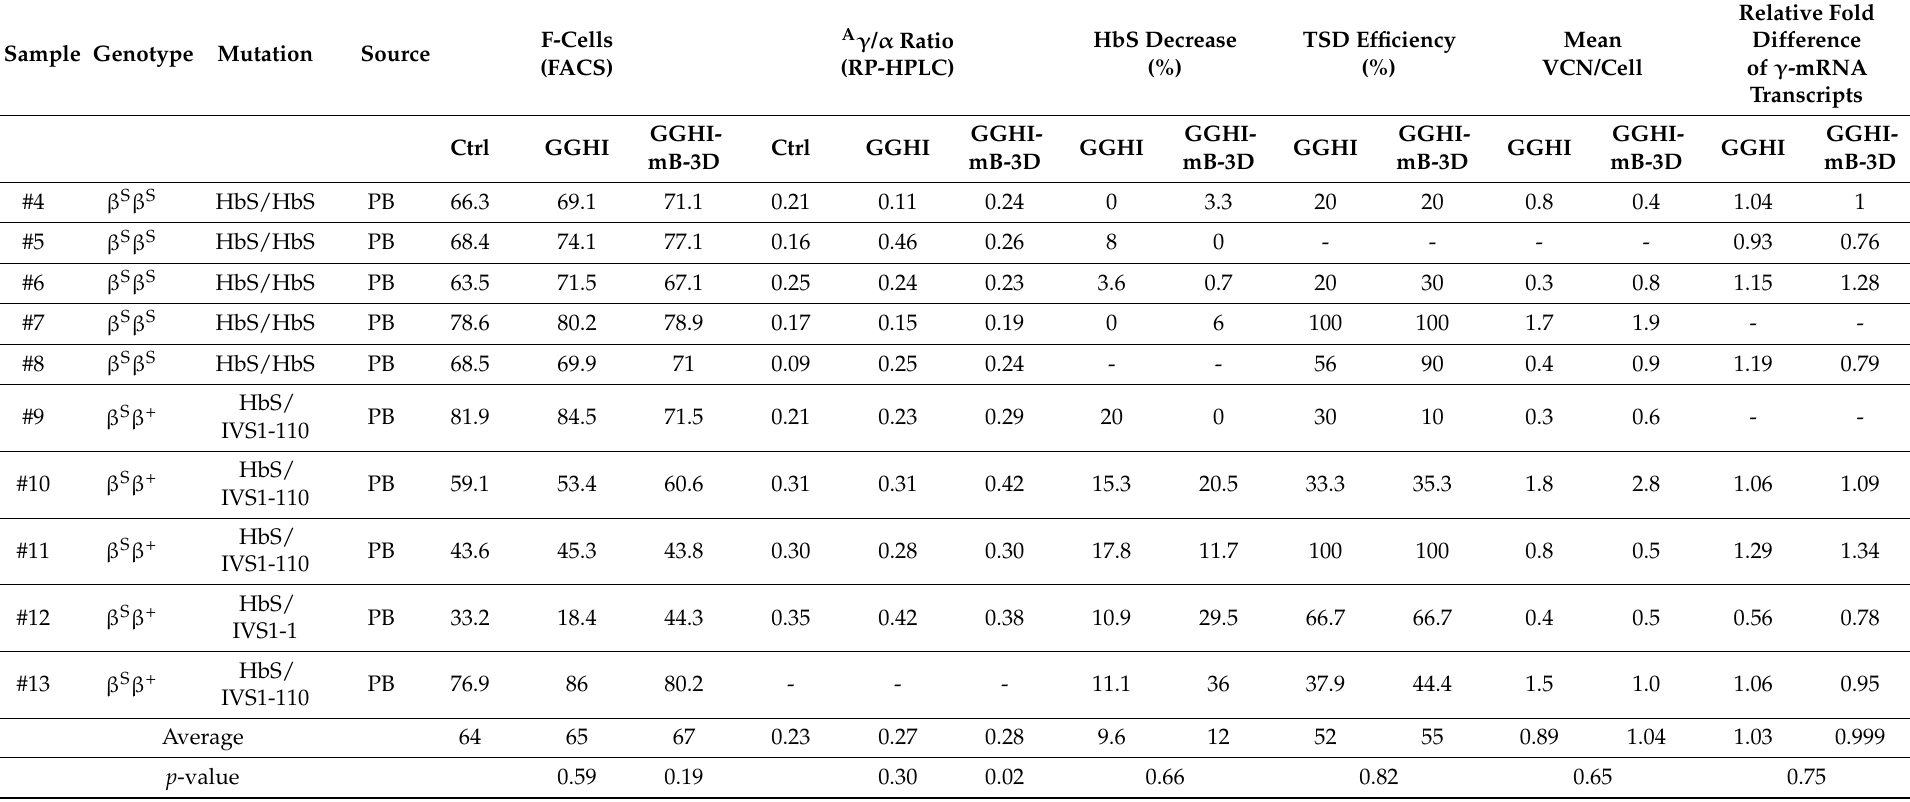
Table 1. Detailed results from all